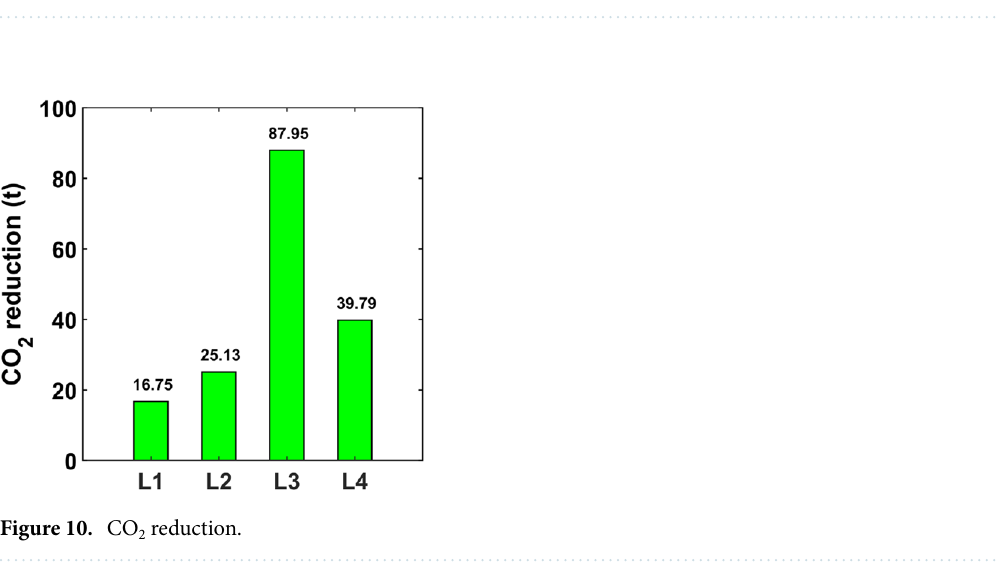
Table 7. Reduction of greenhause gases and other pollutant.